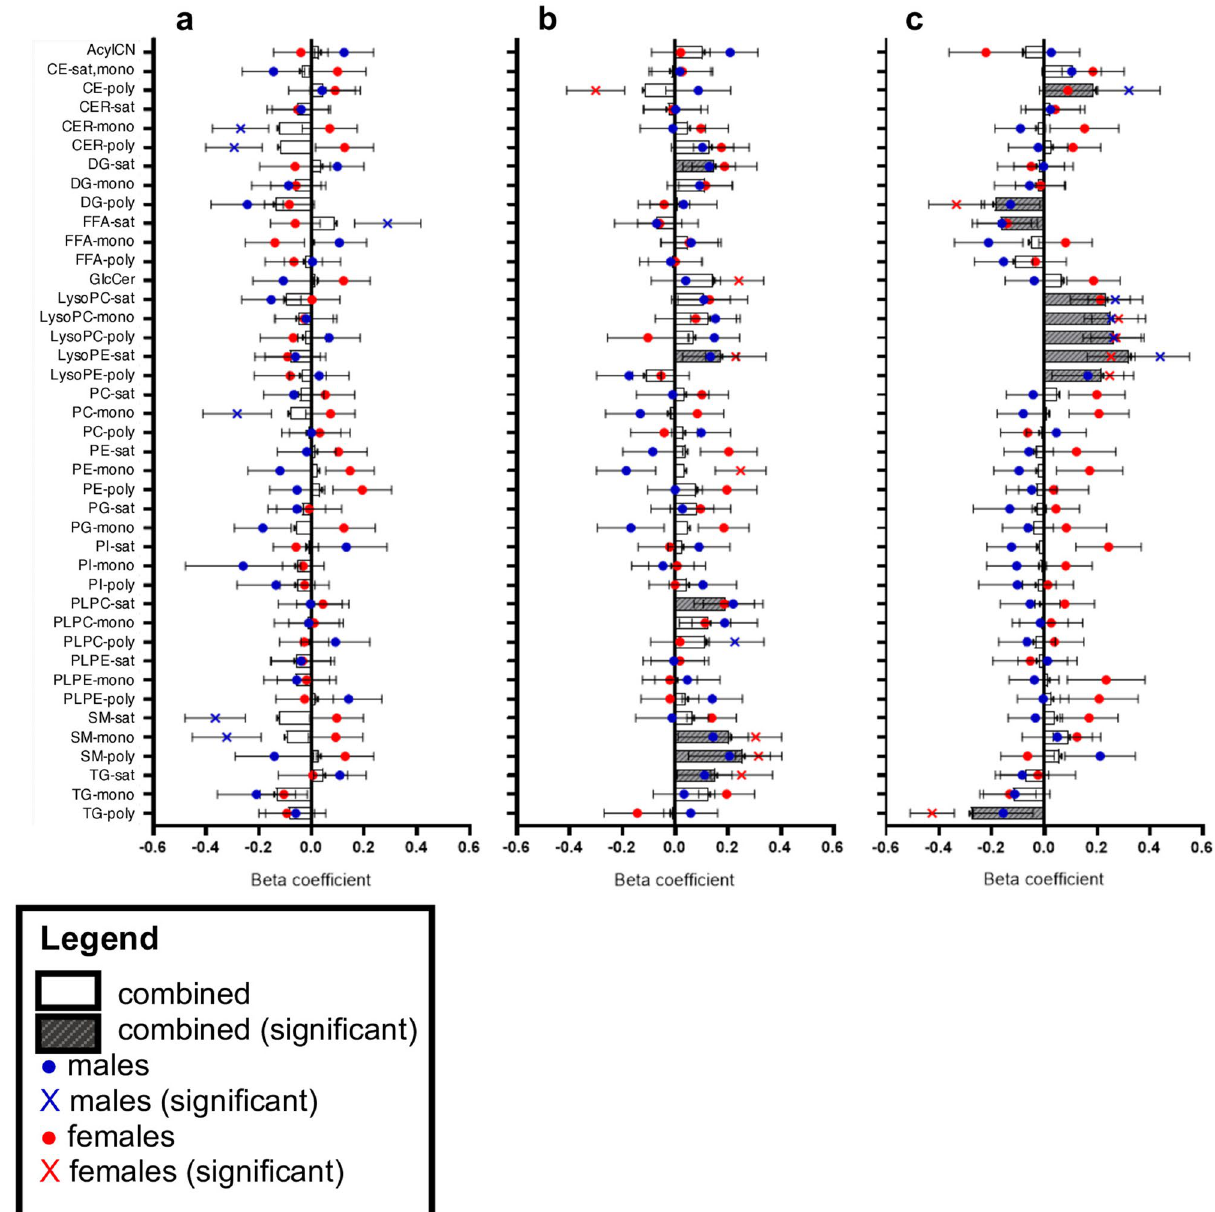
( c ) cord blood and Fenton BW z score, adjusting for sex, maternal age, parity, gestational age, baseline BMI, and GWG. For the combined model, beta coefficients plotted as gray bars (β ± SE) with significance depicted as gray striped bars (α = 0.05). Sex stratified models were run. For males, beta coefficients are plotted as blue dots (β ± SE) with significance depicted as blue “X” (α = 0.05). For females, beta coefficients are plotted as red dots (β ± SE) with significance depicted as red “X” (α =